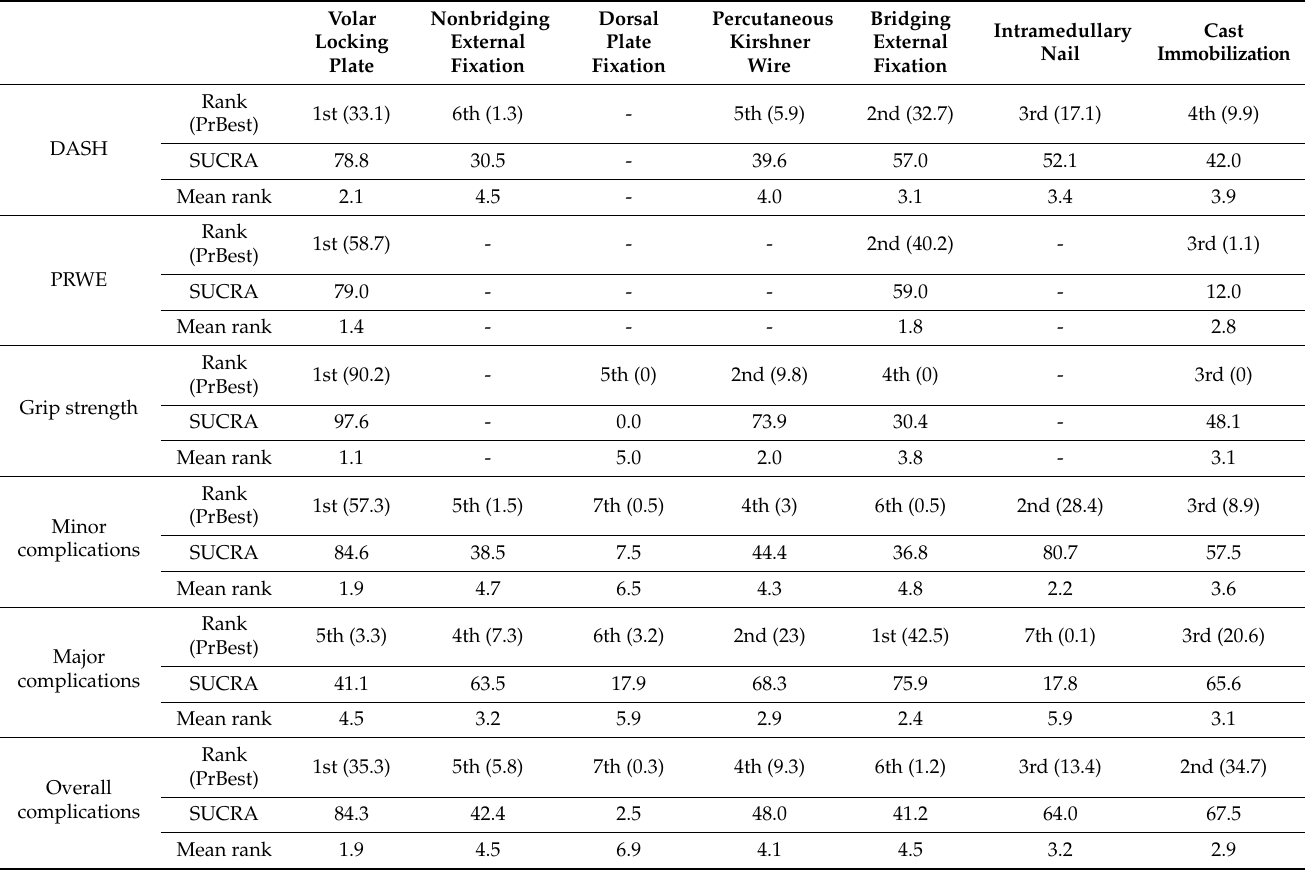
Table 4. Relative rankings of SUCRA values for functional outcomes and complications of different treatment modalities. Volar Nonbridging Locking External Plate